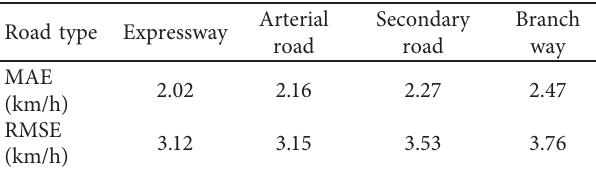
Figure 16: Classification of road network, where the red sections are expressways, the orange sections are the arterial roads, the green sections are the secondary roads, and the gray sections are the branch roads. Table 5: Evaluation of the prediction results for each road